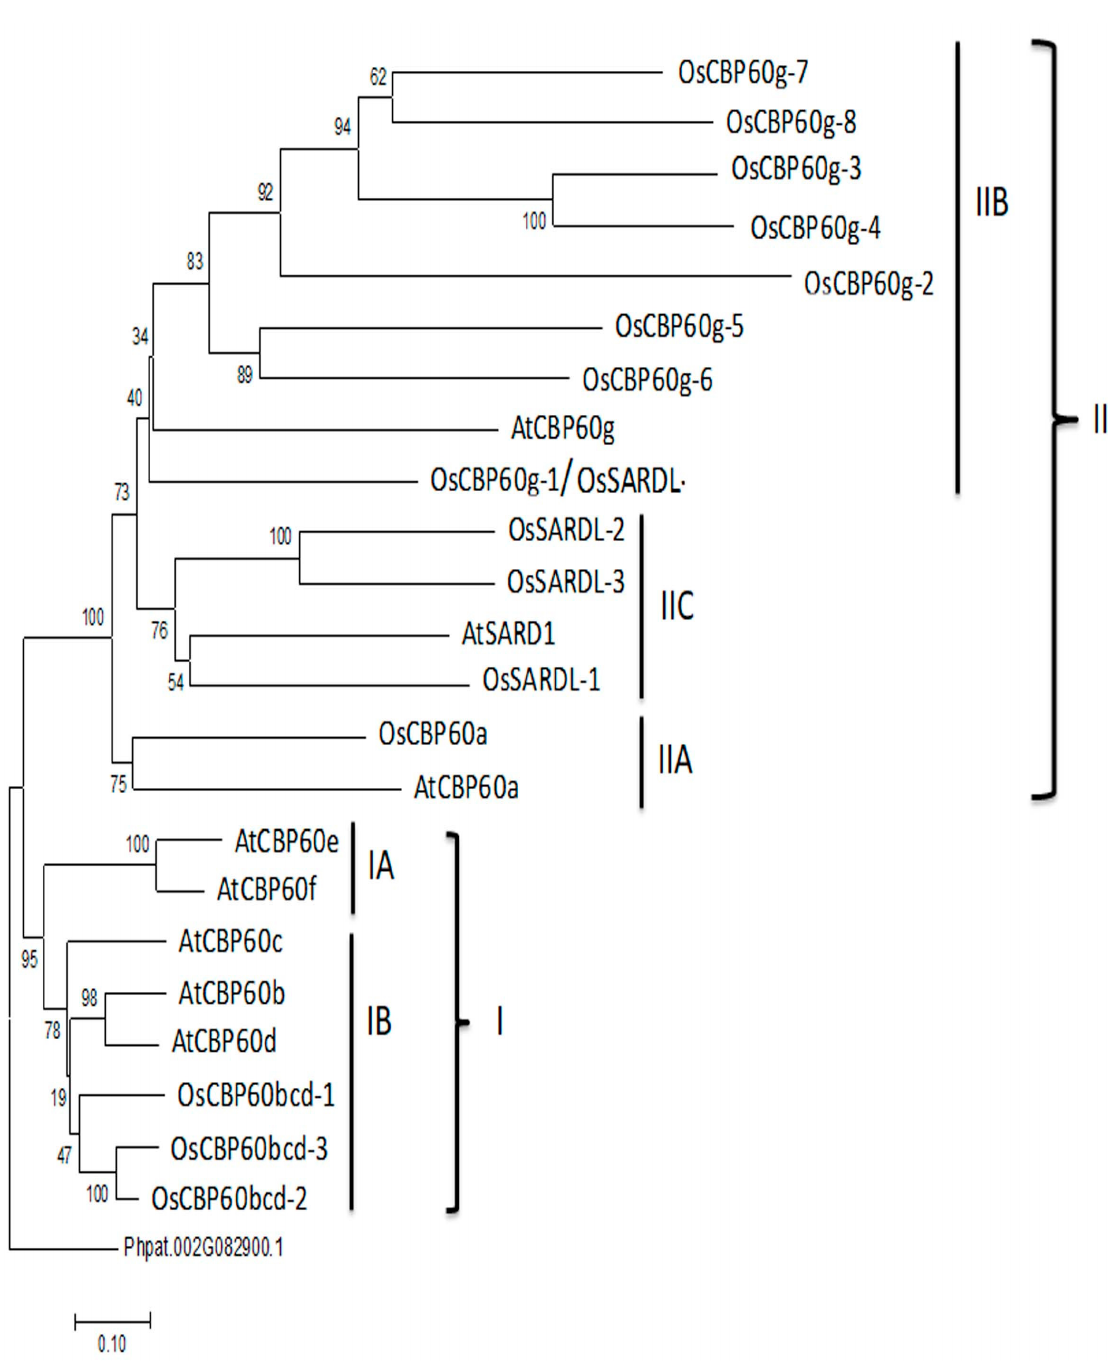
Figure 1. Phylogenetic tree showing relationships of the CBP60 proteins of rice and Arabidopsis. AtCBP60 and OsCBP60 sequences were obtained from TAIR and Phytozome 11, respectively. Phyloge- netic tree was generated by the neighbor-joining method using MEGA7 software after alignment of the CBP60 sequences using MUSCLE. The tree was rooted with the moss homologue Phpat.002G082900. Bootstrap values from 500 replicates are shown at each node. The scale bar indicates 0.1 amino acid substitutions per site. Clade I and II and their sub-clades are indicated on the